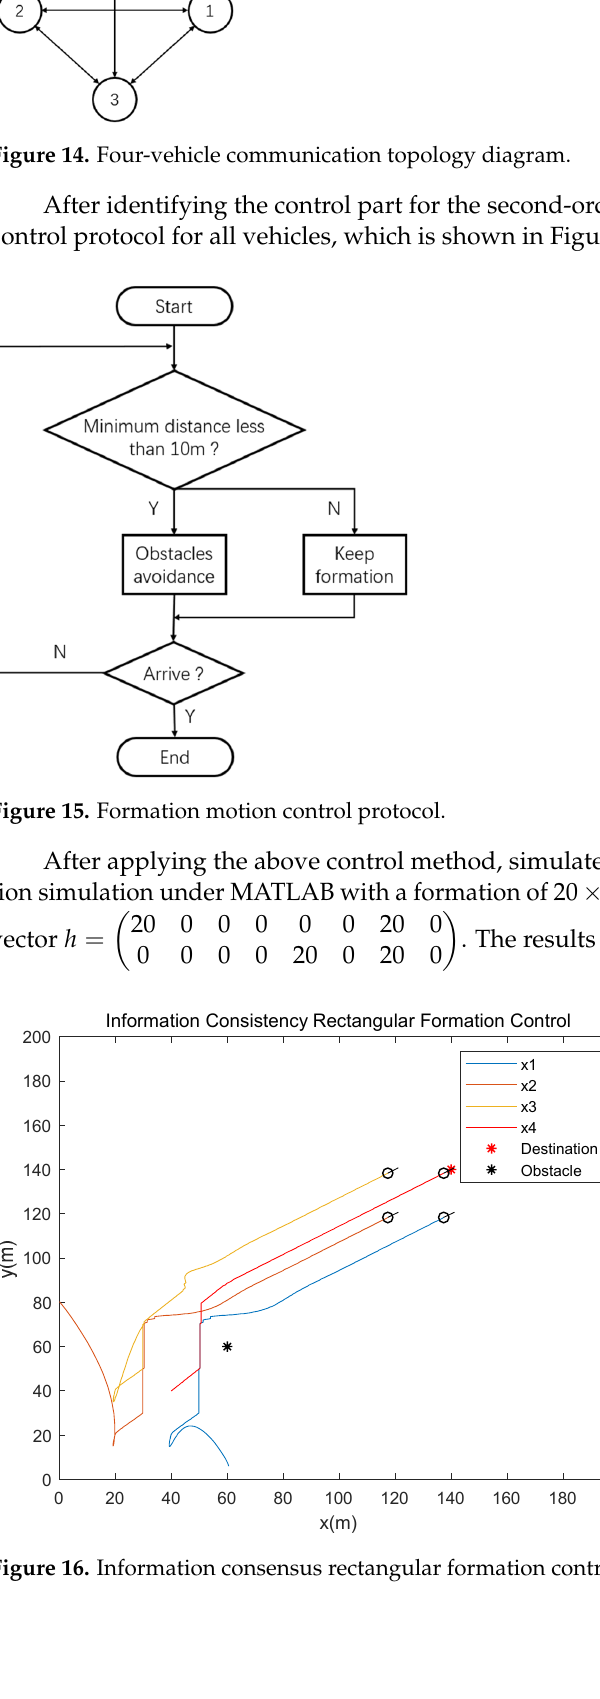
Figure 17. Deviation values of three followers from the desired position. It can be seen that the formation can form and stabilize even when the leader is mov- ing, avoid obstacles normally according to the preset avoidance logic, resume the for- mation immediately after the avoidance and keep moving to the end. 5. Conclusions This paper focuses on the cooperative following control function of mobile robots. In terms of multi-robot following, the leader-follower formation model is developed, and a basic following control method is analyzed in simulation experiments. Then, the en- hanced integral separation feedback following control strategy incorporating the dynamic information is proposed to realize the fast completion of formation and stable following. In the two-robots motion simulation, the optimized following control model is proved to be more effective, as the total error E during the simulation of experiment 3 is 0.3334 m, 57.6% lower than that of experiment 2, which was conducted under the same initial con- ditions, 0.7863 m. Considering the following control in the case of a multi-robot system,